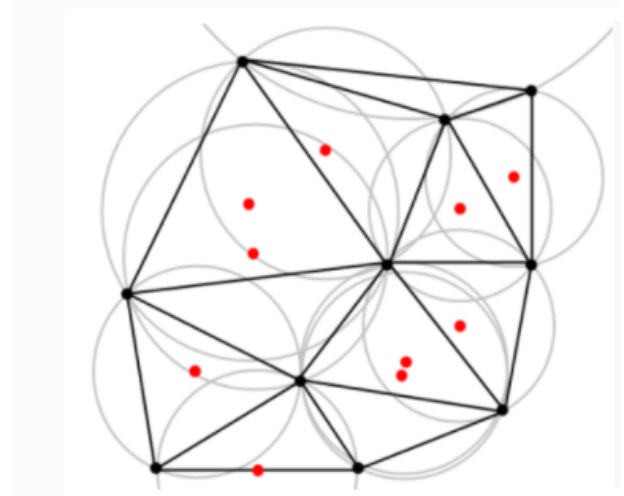
Fig. 1 Joining two adjacent triangular surface